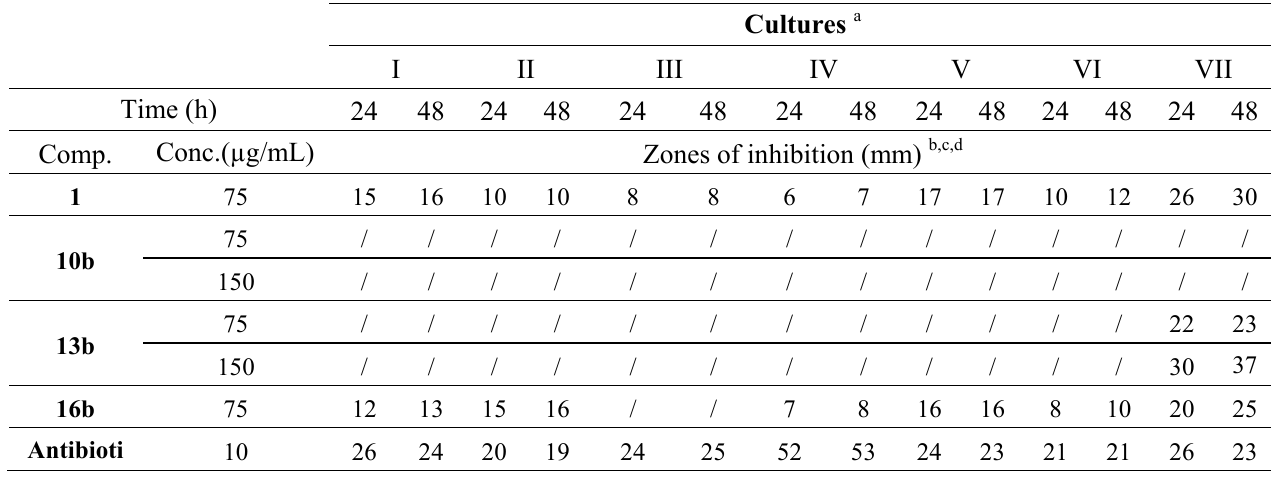
Table 5. Cylinder plate diffusion method (µg/mL) of synthesized